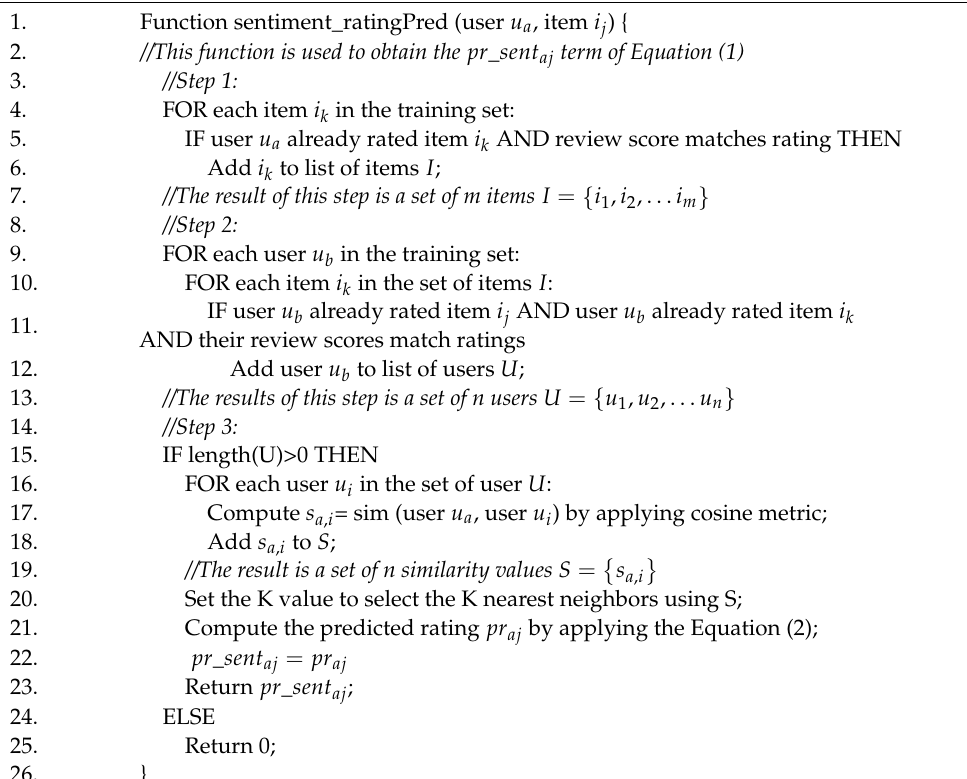
Algorithm 1. Rating prediction based on sentiment for user u a and item i j